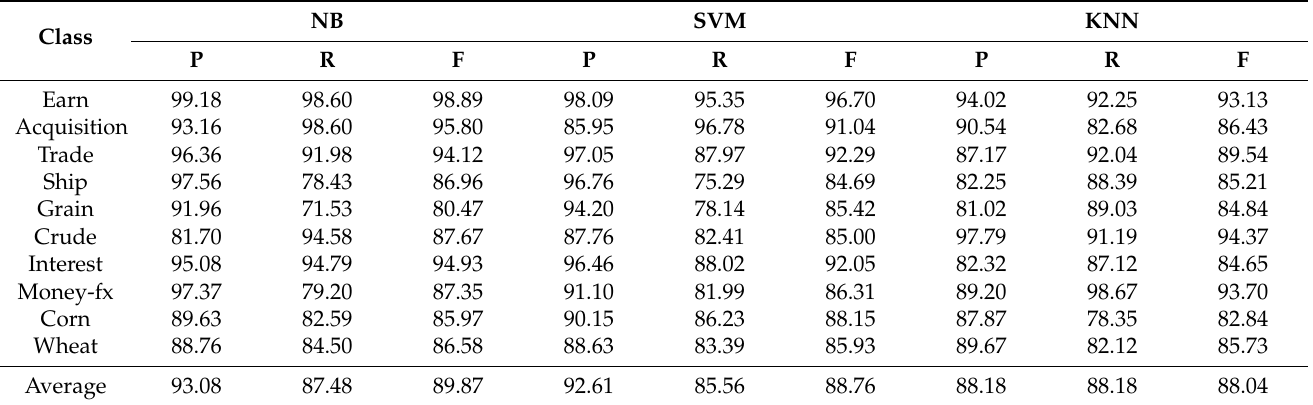
Table 11. Precision (P), Recall (R) and F-measure (F) of each class in the Reuters dataset using the BBA LHS